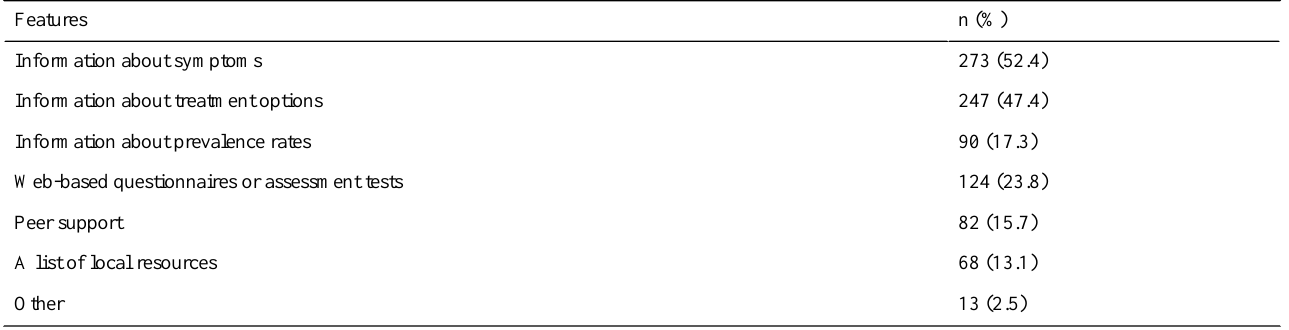
Table 2. Web-based mental health information-seeking tendencies (n=521).